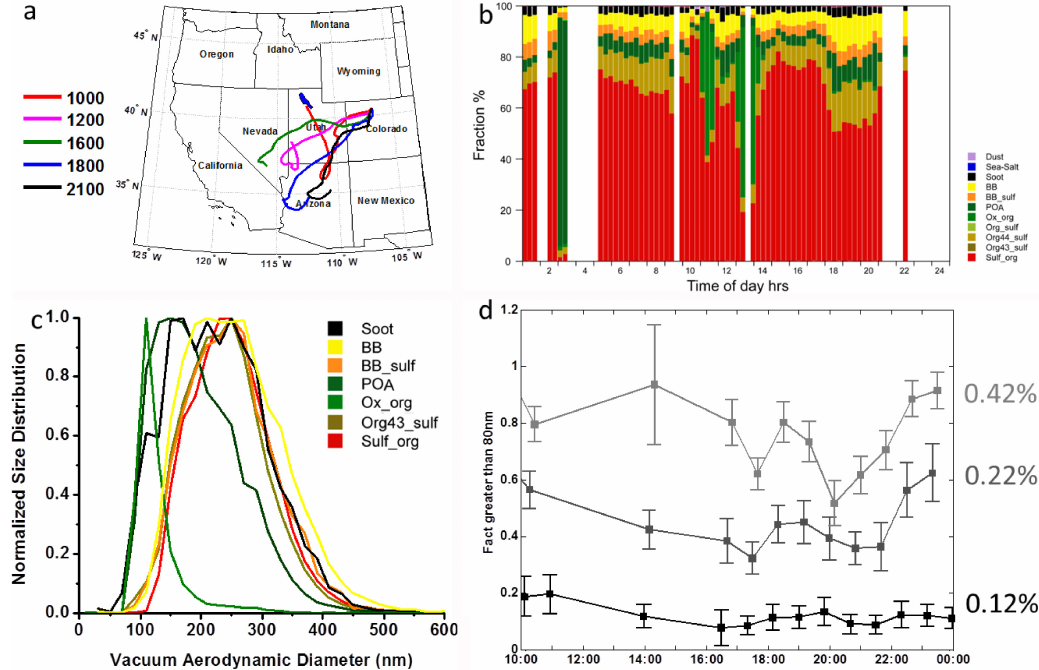
Fig. 4. (a) back trajectories at a variety of times throughout the day on 7 March. (b) time evolution of composition throughout the day, as measured by SPLAT. (c) Composition-resolved size distributions. Colors are the same as the composition plot (b) . (d) Activated fraction of particles greater than 80nm as a function of measured CCN supersaturation and time of day on 5 March.